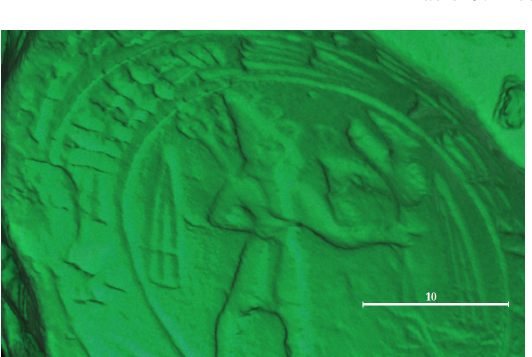
Table 5: Processing time on Agisoft